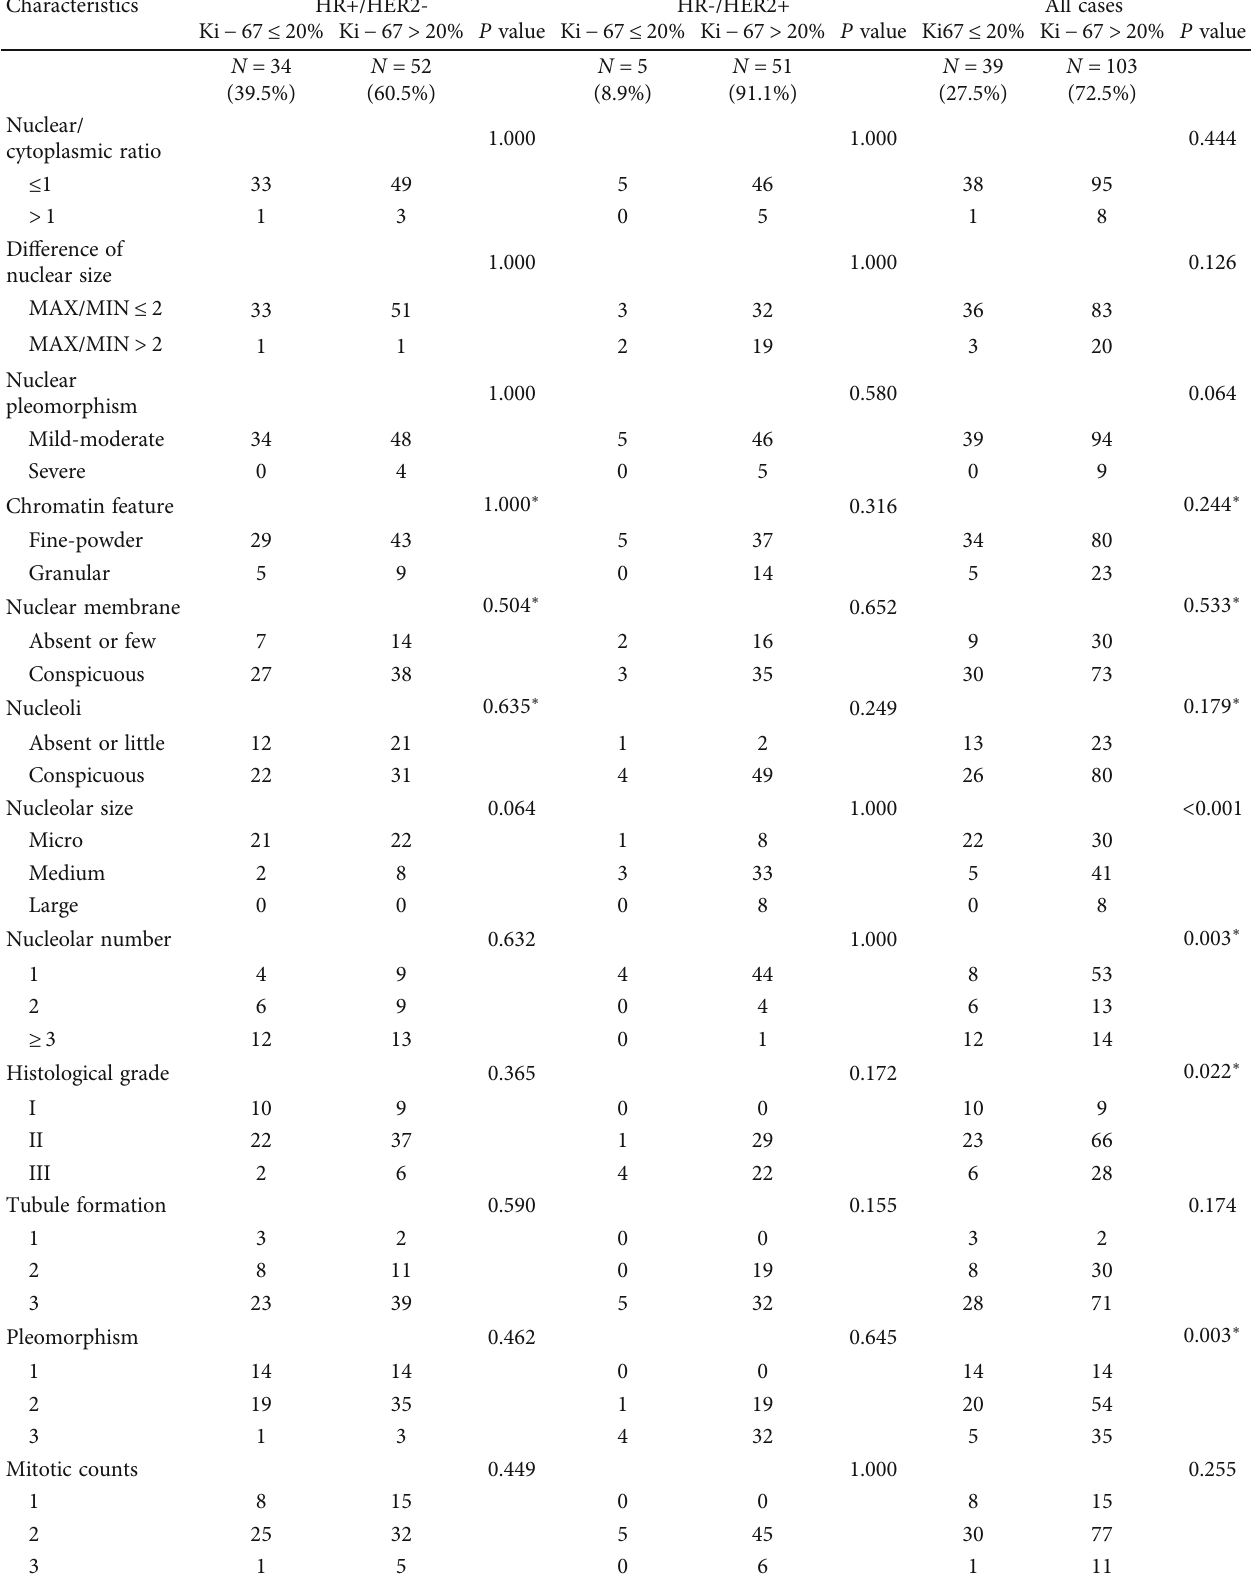
Table 3: Nuclear morphological characteristics of the invasive breast cancer with Ki-67 expression.